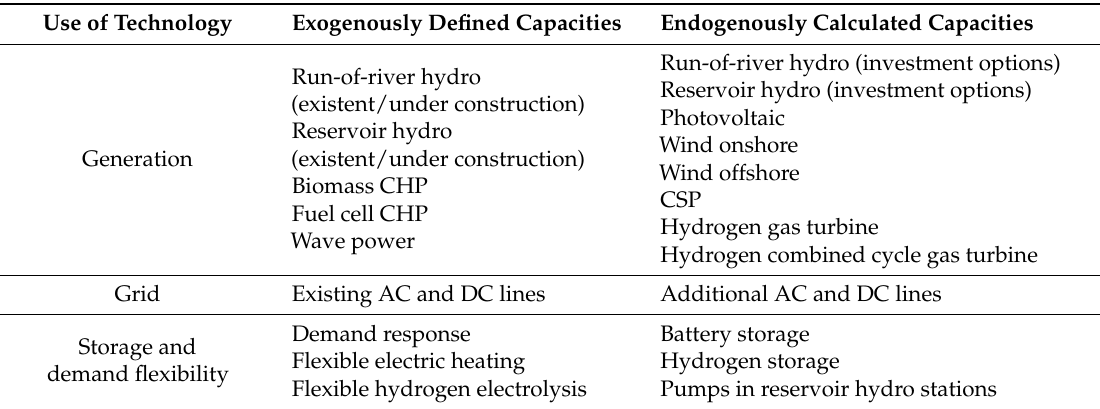
Table 1. Overview of considered technologies.